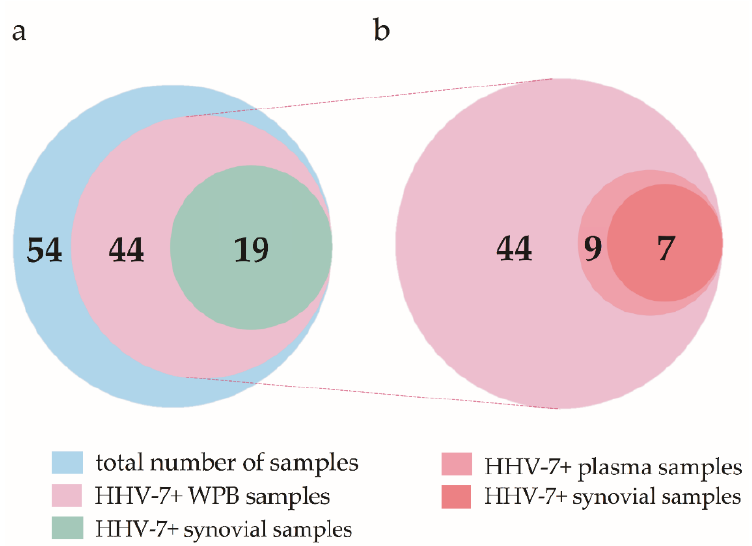
Figure 1. Distribution of patients enrolled in the study according to nested PCR data. ( a ) Venn diagram circles are scaled according to the number of samples and depict the total number, the number of human herpesvirus 7 (HHV-7)-positive whole peripheral blood (WPB), and the synovial membrane tissue samples. ( b ) Extract from the HHV-7 PCR+ group depicts the number of positive samples detected in the case of persistent and active viral infection (blood plasma and synovial membrane samples).